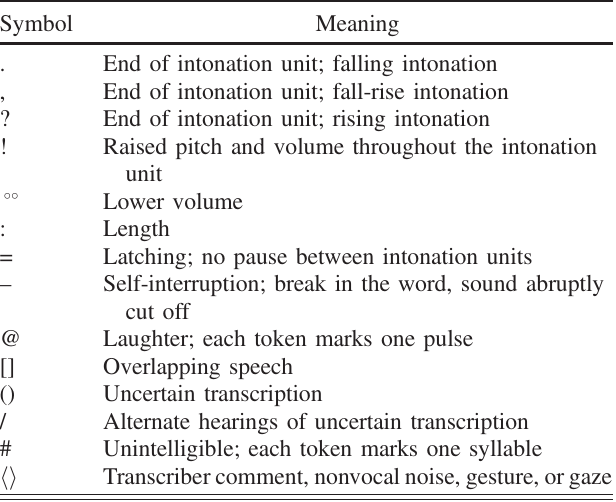
TABLE III. Transcript